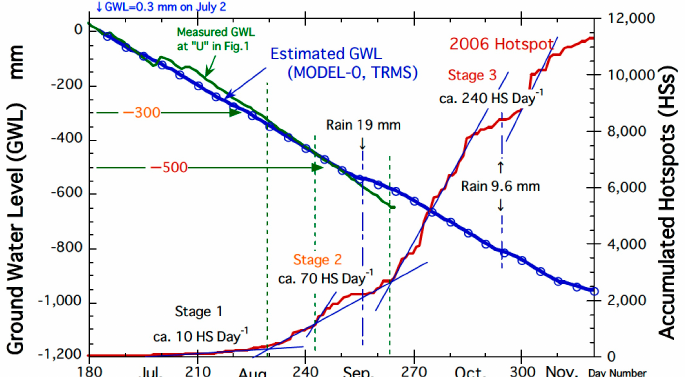
Figure 9. Fire trend and estimated GWL in 2015. Rainfall data from TRMS, GWL on June 25 (DN = 176) were set to 0 mm.